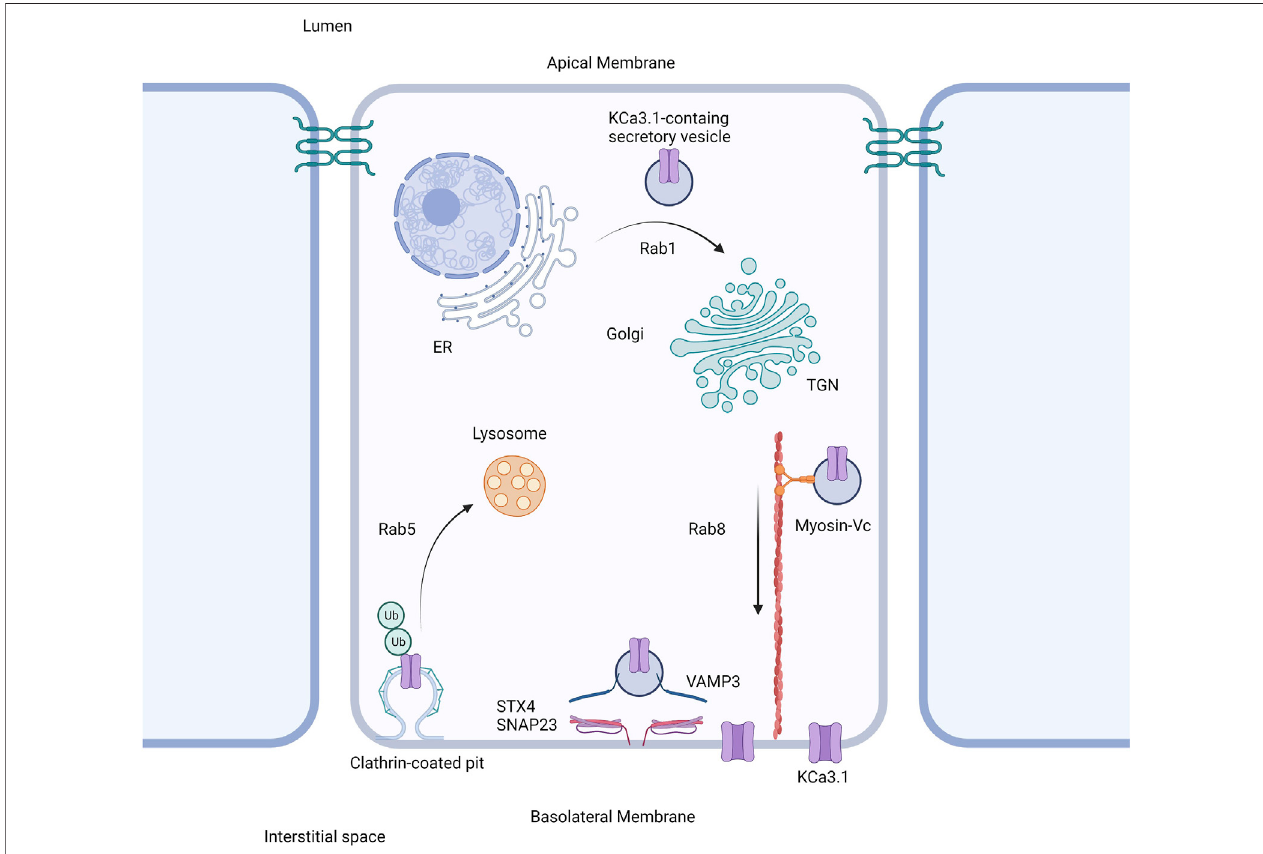
FIGURE 6 | Proposed cell model of the role of SNARE proteins in the targeting of KCa3.1 to the basolateral membrane. After being traf fi cked to the basolateral membraneinaRab1,Rab8,andmyosin-Vcdependentpathway,theSNAREproteinsVAMP3,SNAP-23,andSTX4formaproteincomplexresultingintheincorporation and fusion of the KCa3.1-containing vesicle with the basolateral membrane. Thereupon KCa3.1 is inserted into the basolateral membrane. Figure created with BioRender. ER, endoplasmic reticulum; TGN, trans -Golgi Network; Ub, ubiquitin.